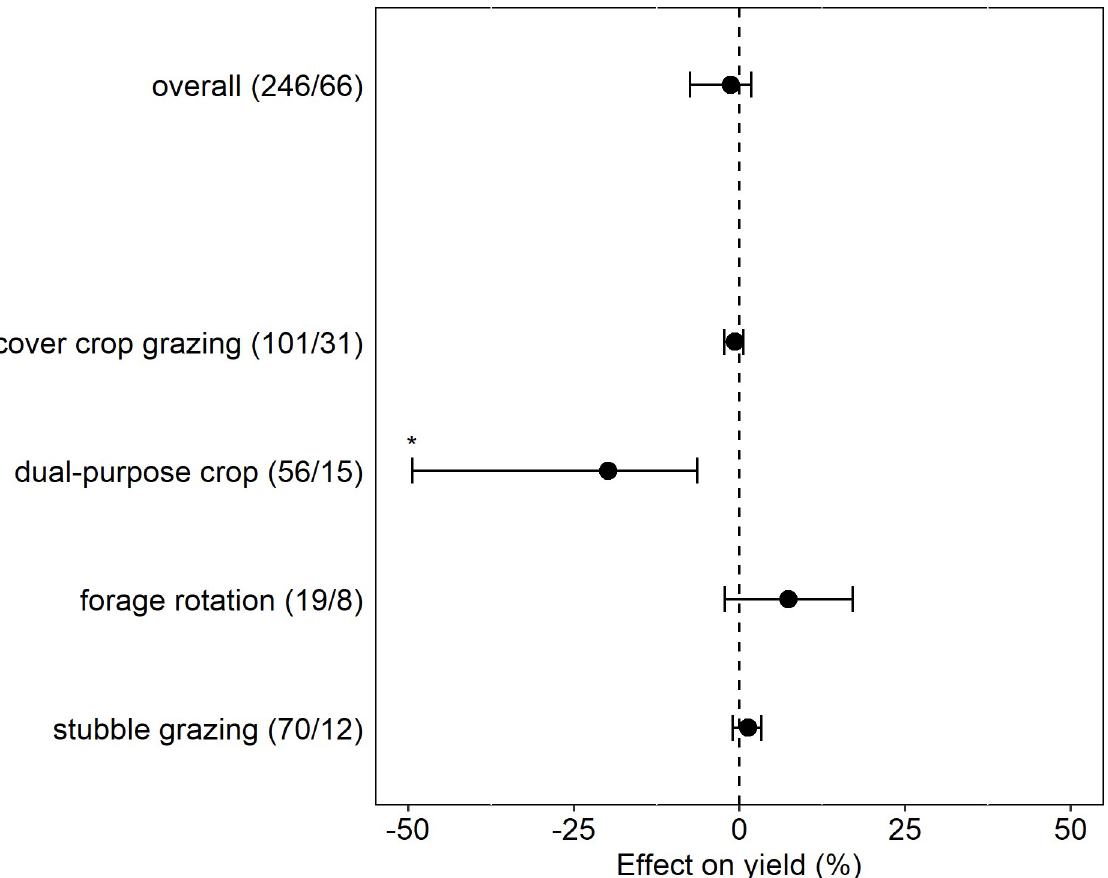
Fig 3. Overall effect of ICLS on crop yield and effect within different ICLS system types. Number of observations/number of studies for each category appears in parentheses. Points represent grazed system yield effect, while the dotted vertical line represents the paired ungrazed system yield. Error bars represent 95% bias-corrected-accelerated bootstrap confidence intervals. Asterisks ( � ) represent a significant yield response in grazed systems relative to ungrazed systems at the 95% confidence level.